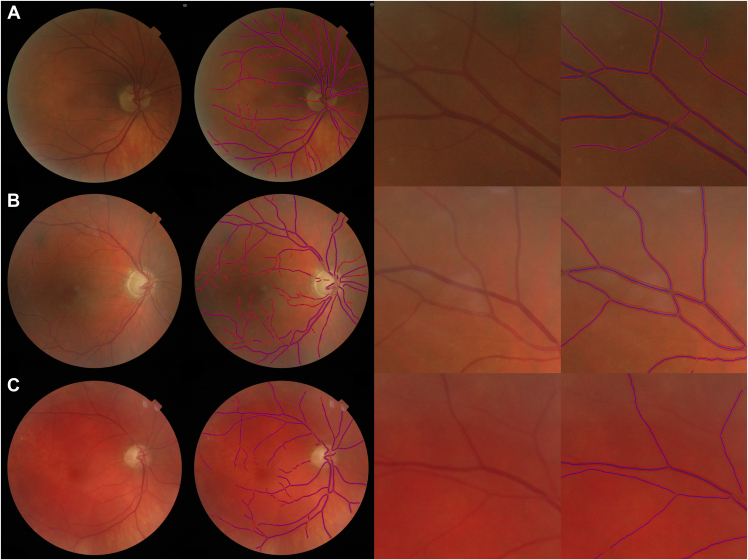
Demonstration of QUARTZ output showing narrow arterioles in the superior arcade of a patient with high-tension glaucoma (HTG) (B) and narrow venules in another patient with HTG (C), compared with a healthy subject (A).